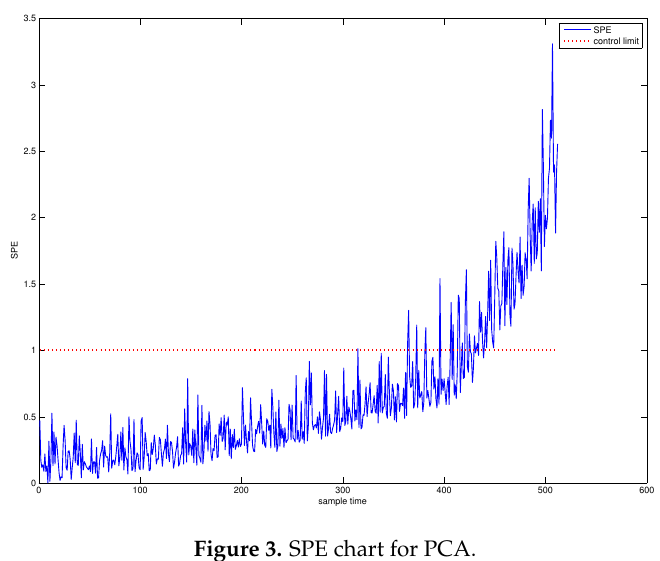
Figure 3. SPE chart for PCA.